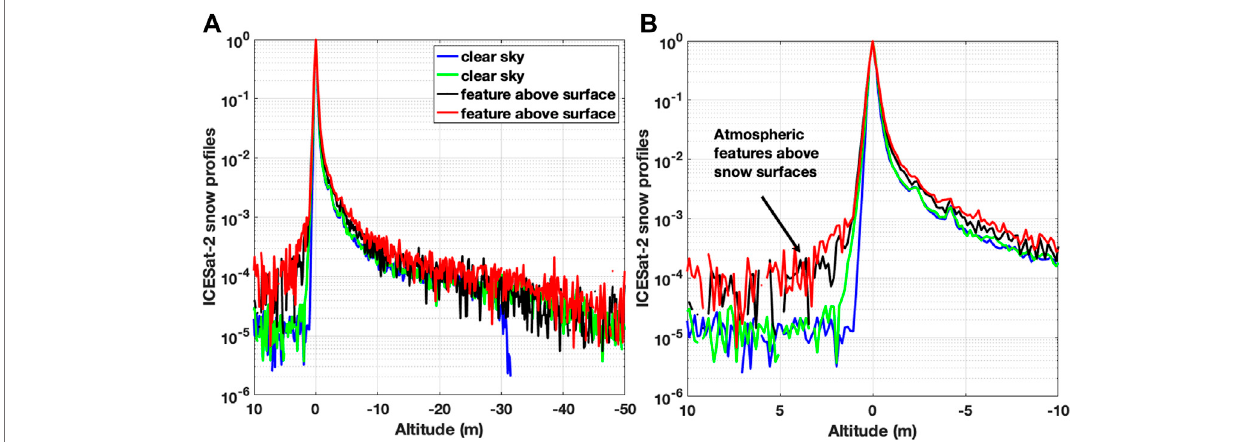
FIGURE 8 | (A) Snow pro fi les derived from the ICESat-2 data under different atmospheric conditions over Antarctica: almost clear sky (blue and green) and non- clearsky(blackandred). (B) Sameas (A) butzoomingintothealtituderangeof10to − 10 m.Thepulsestretchingofsnowpro fi lesduetoatmosphericforwardscattering can be clearly seen from black and red